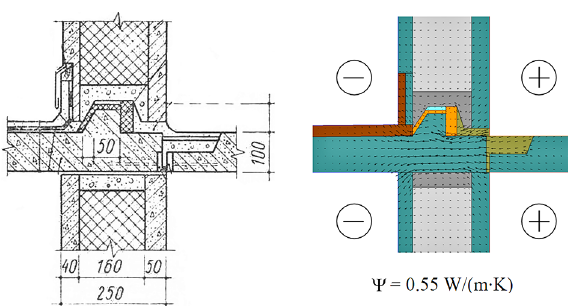
Fig. 6. Original drawing from the design documentation of the external wall/inserted ceiling at balcony junction (left) and heat flux vectors with the calculated linear thermal transmittance Ψ